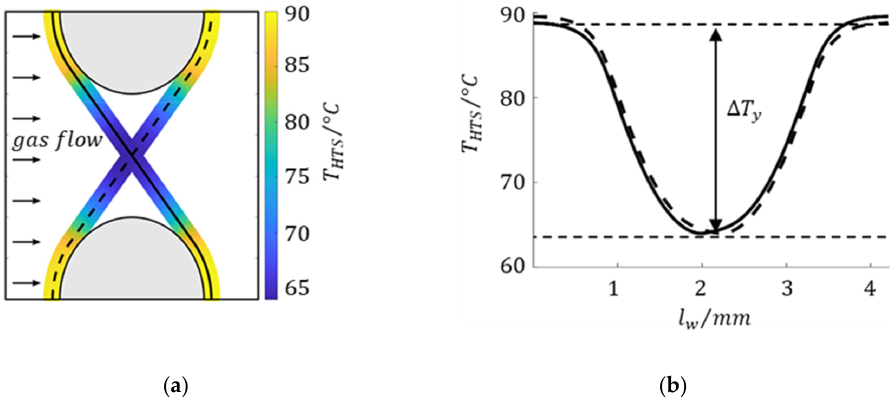
Figure 14. Temperature distribution in ( a ) and along ( b ) the two wires calculated for geometry V1 (see Table 2) and an inflow velocity of 2.0 m / s.